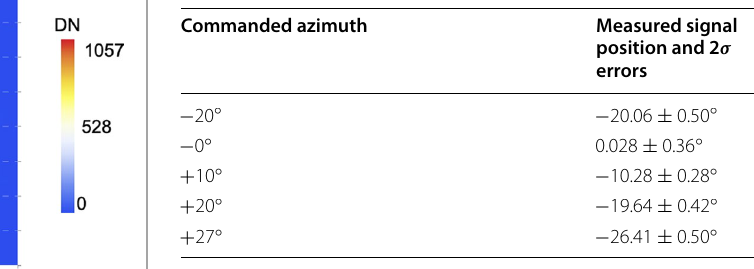
Table 3 Measured angular errors for an azimuthal scan of